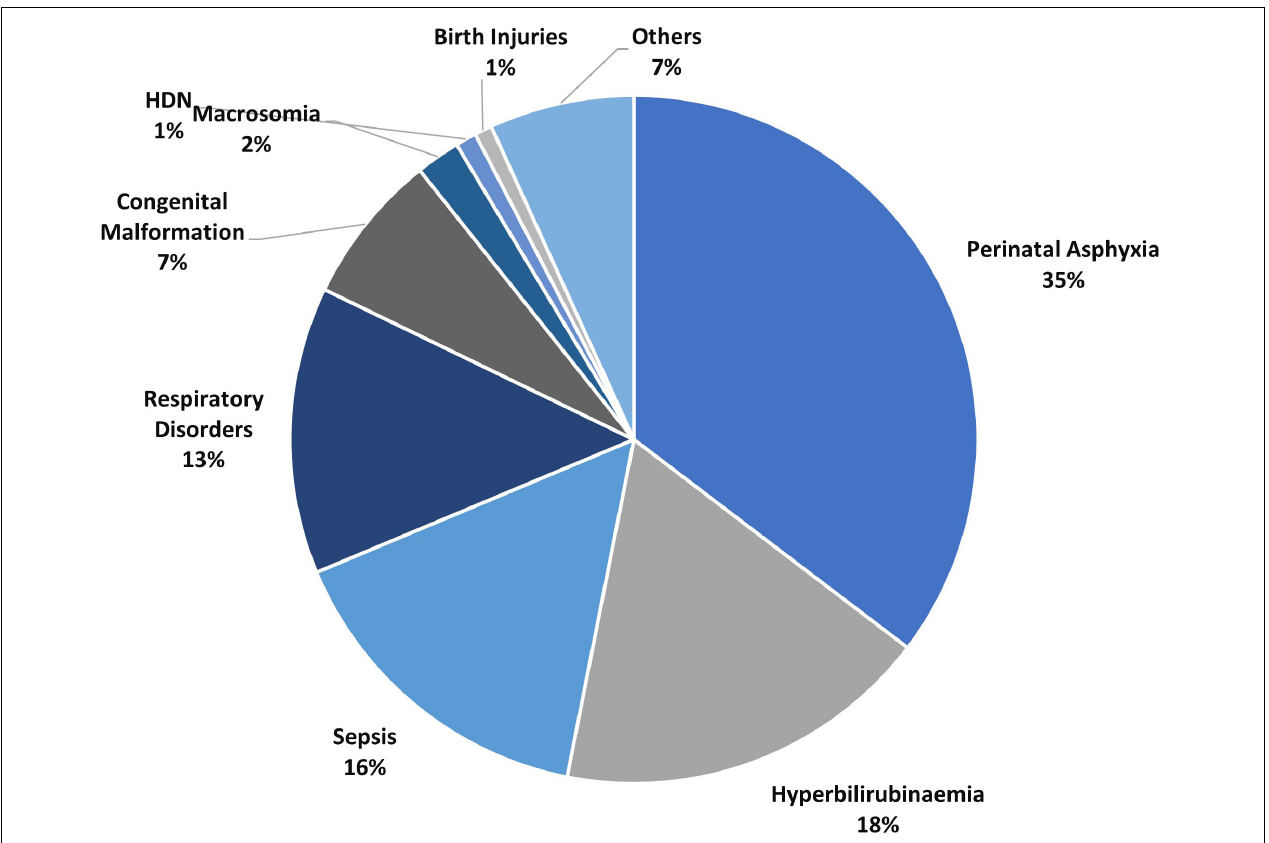
FIGURE 2 | Morbidity pattern among 9,030 term